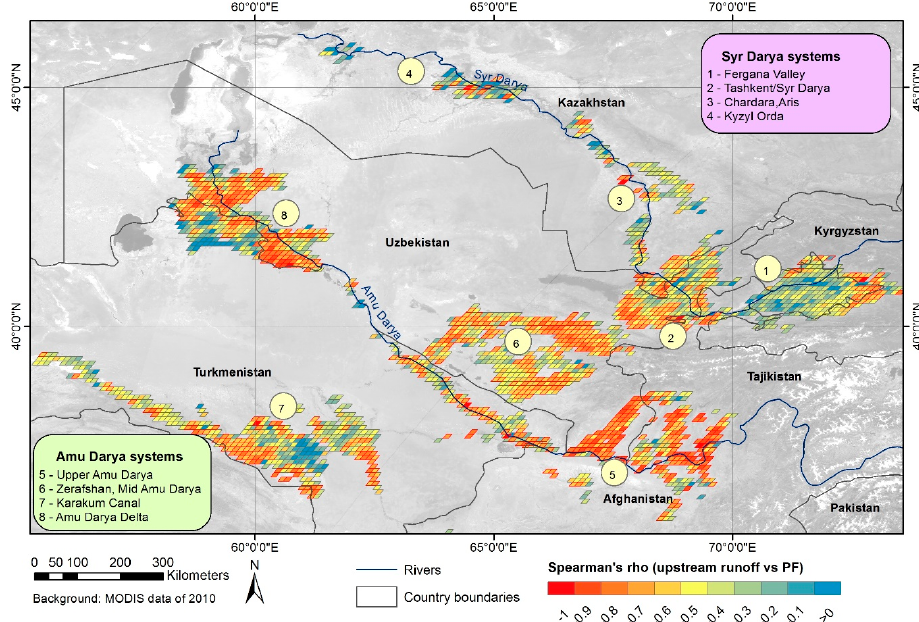
Figure 10. Spearman’s rho of correlation between the percentages of fallow cropland (PF) annually averaged in 10 km × 10 km grid cells and annual upstream runoff formation in hydrological years between 2000 and 2012 (13 years). Significant correlations (at 95% level) are highlighted in yellow to red. Only grid cells with more than 100 MODIS pixels of the iCE were included (>625 ha).